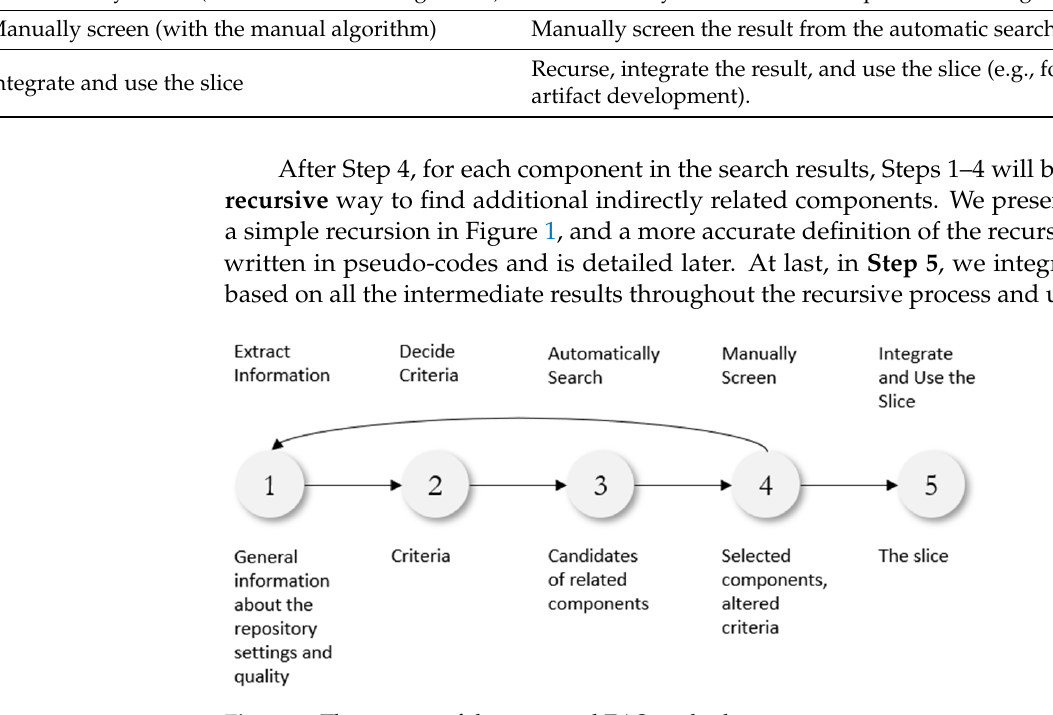
Figure 1. The process of the proposed EAS method.